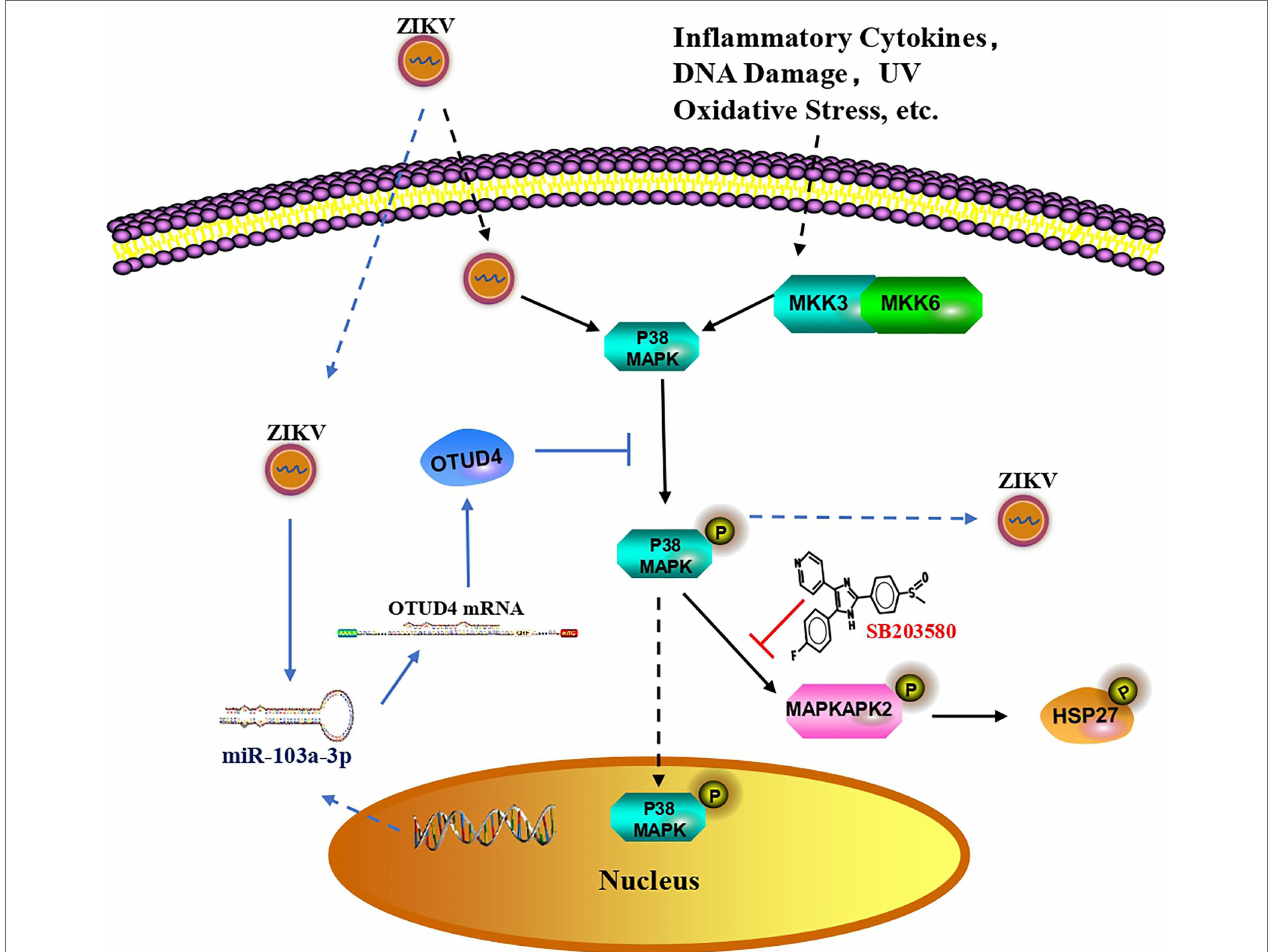
FIGURE 6 | Proposed model for miR-103a-3p regulates ZIKV replication. In response to ZIKV infection, p38 MAPK is activated as shown by increased phosphorylated of HSP27 which facilitates ZIKV replication. Suppressed activity of p38 MAPK by SB203580 inhibits ZIKV replication. ZIKV infection also induces miR-103a-3p expression, which targets OTUD4 to regulate p38 MAPK signaling pathway to stimulate ZIKV replication. MiR-103a-3p is one of the host genes exploited by ZIKV to benefit its replication and targeting this gene or the p38 MAPK signaling pathway may be a potential novel strategy to treat ZIKV